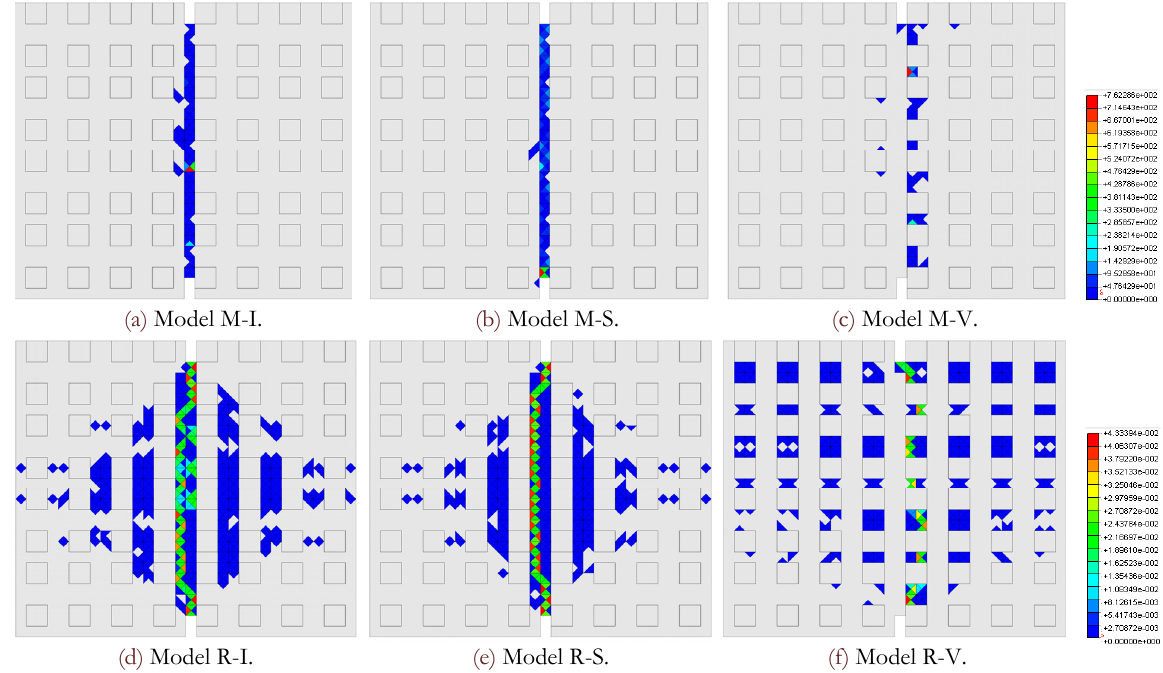
Figure 7: Crack distribution in models at the final stage of